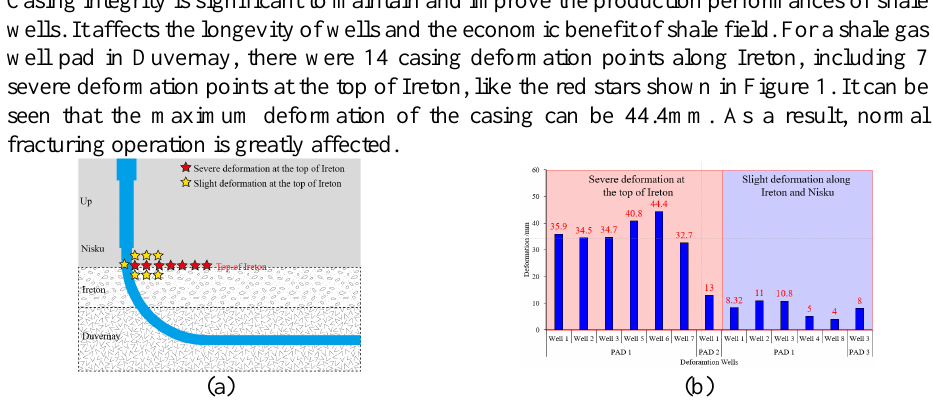
Fig. 1. Casing deformation at the top of Ireton during fracturing